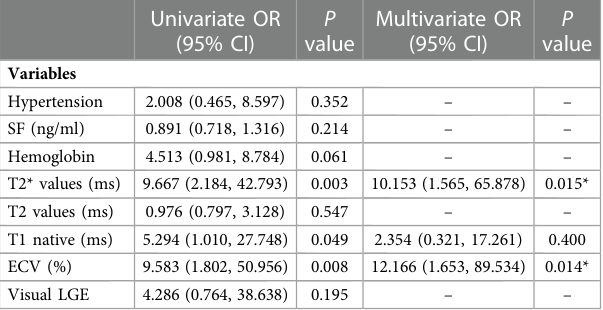
*Denotes signi fi cant values. Abbreviations as in Tables 1 , 2 .